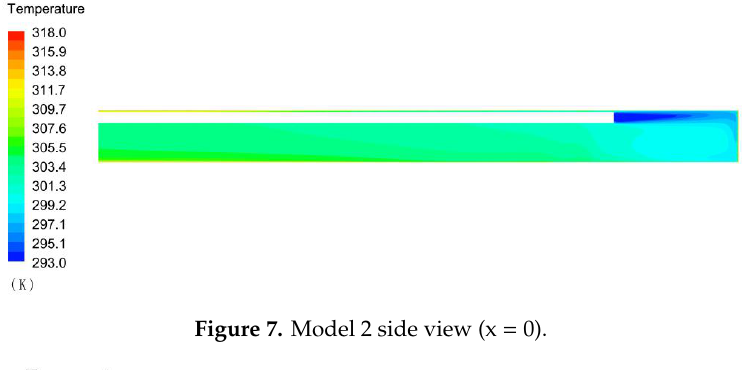
Figure 7. Model 2 side view (x = 0).